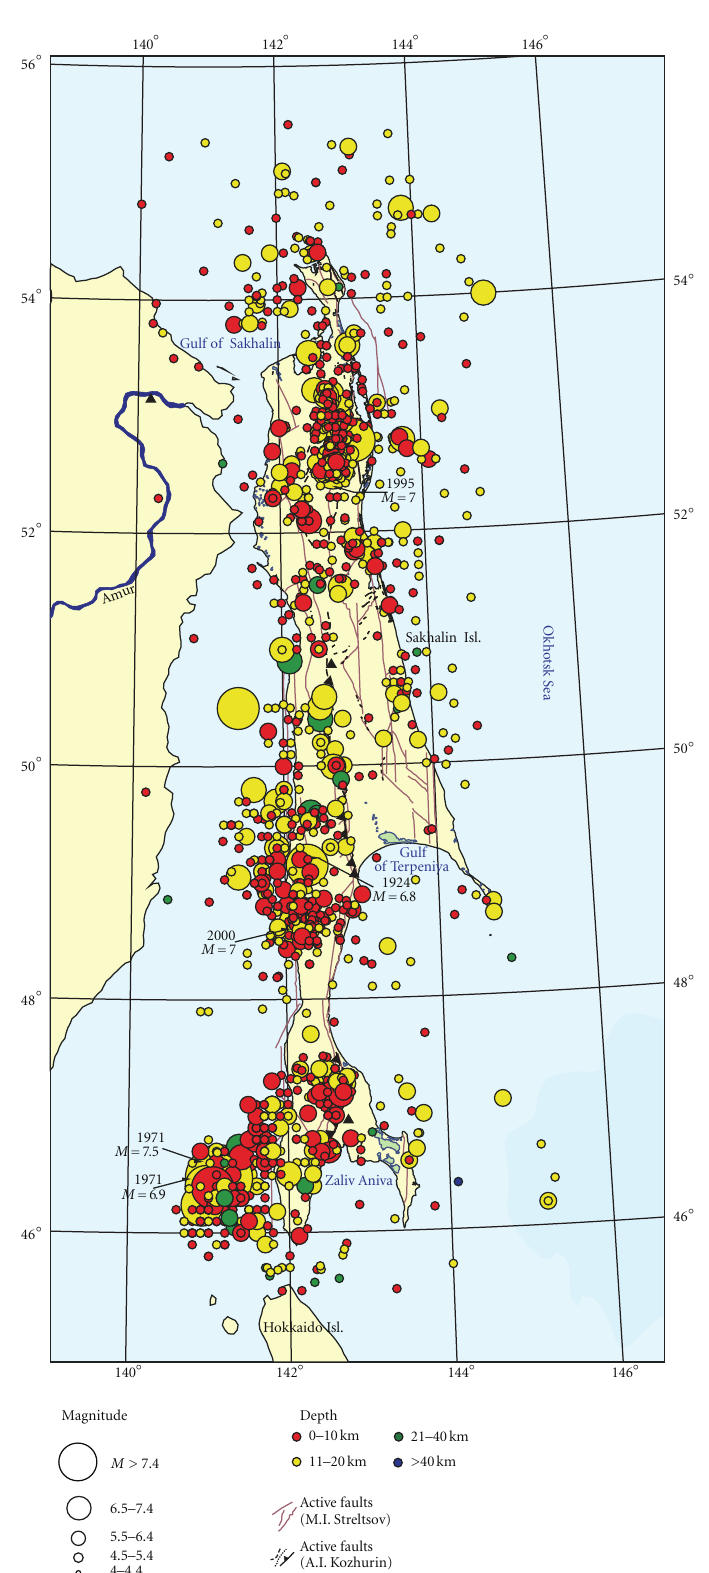
Figure 4: Map of crustal M S ≥ 3 . 5 earthquake of the Sakhalin region, 1906–2010. Date and magnitude is given for the strongest